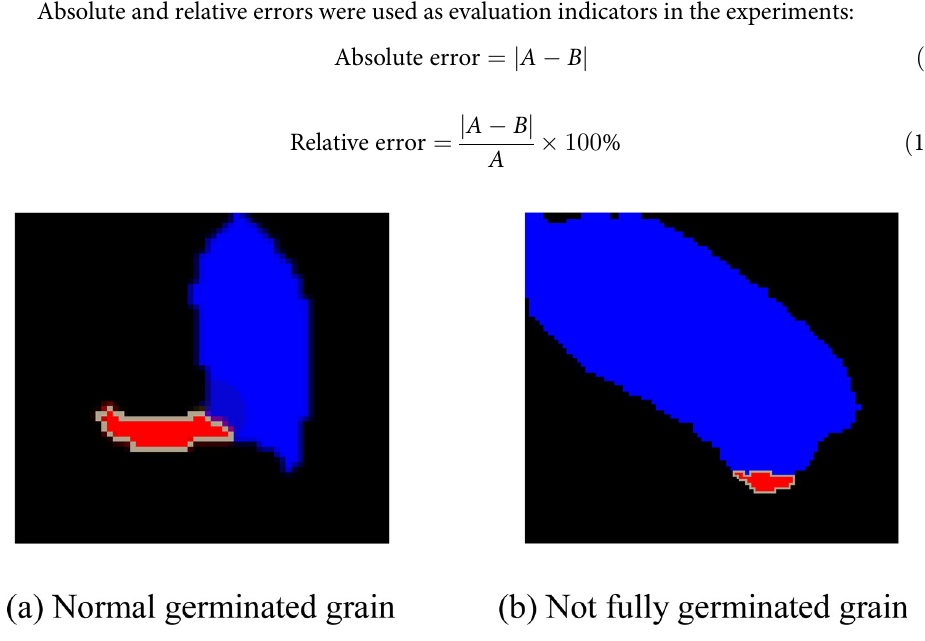
Fig 8. Example of germinated grain.